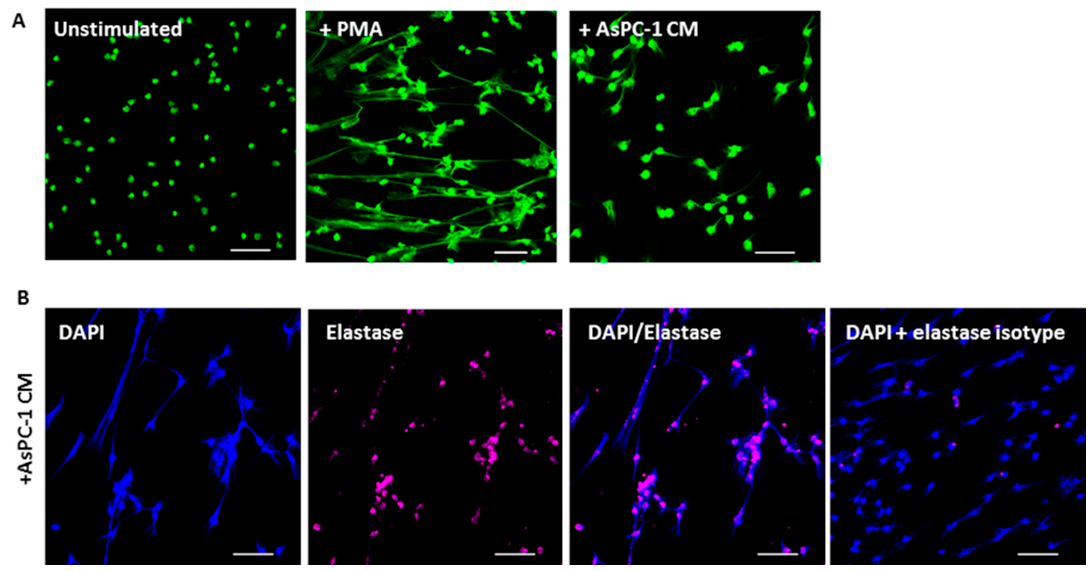
Figure 3. Confocal microscopy images of NETs induced by AsPC-1 conditioned media. ( A ) Neutrophils were incubated on poly-l-lysine coated glass slides and left either unstimulated, or were stimulated with PMA for 3 h, or AsPC-1 CM for 30 min. Neutrophils were fixed with paraformaldehyde and stained with Sytox (green) to visualise extracellular DNA. Images representative of three independent experiments; ( B ) AsPC-1 stimulated neutrophils were also stained with anti-elastase (pink) to visualise elastase bound on NETs. DAPI (blue) was also used as an alternative to visualise DNA. Elastase staining was above isotype control. Images representative of two independent experiments. Scale bar = 50 μ m.